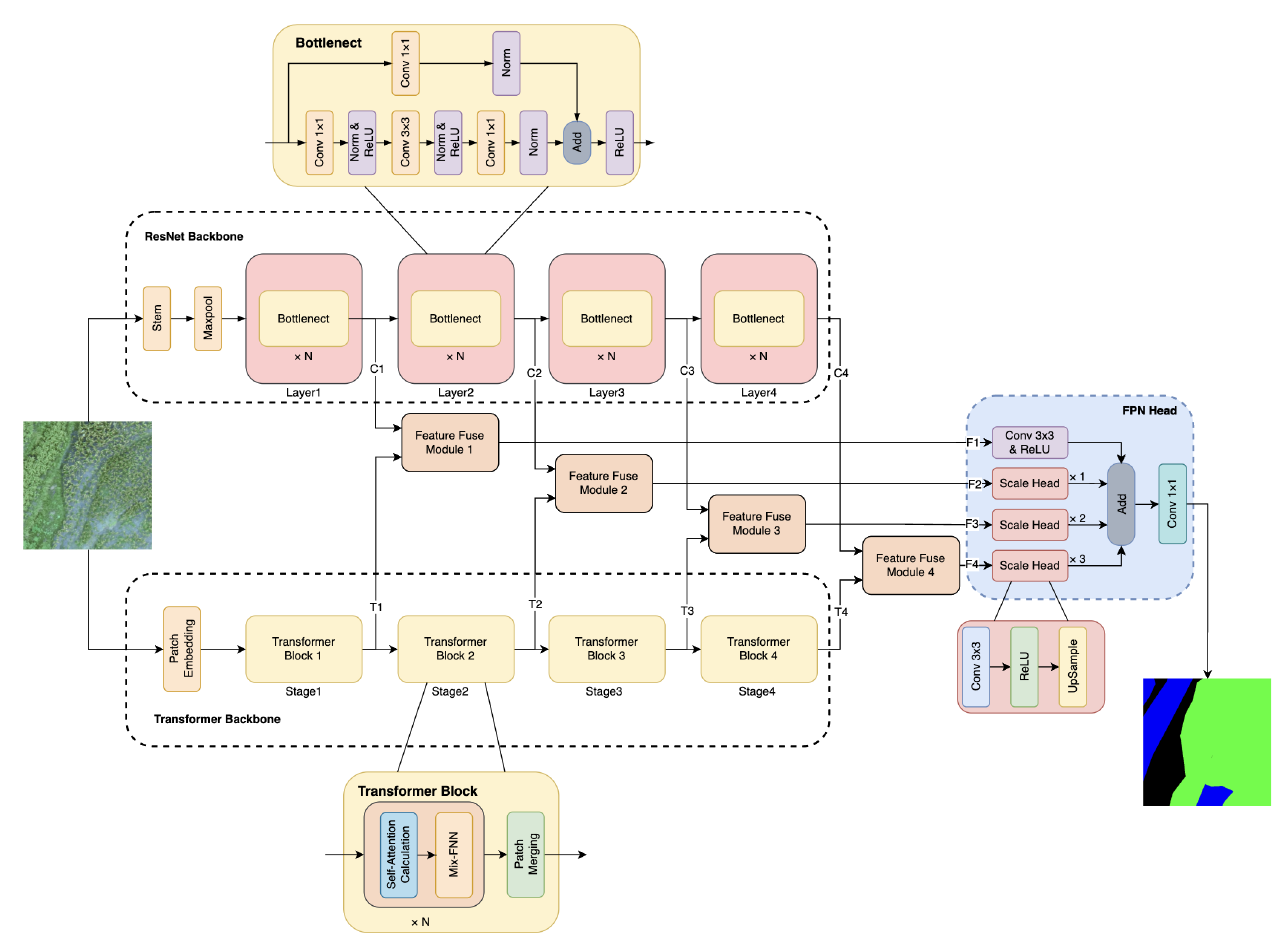
Figure 1. The framework of the proposed CTFuseNet for accurate crop-type